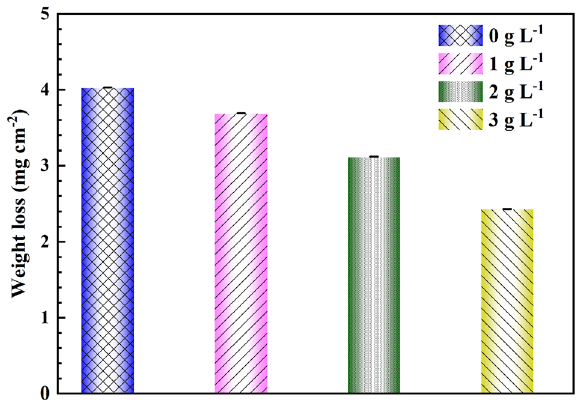
Fig. 7 Weight losses of X80 coupons. The samples were exposed to 3.5 wt% NaCl containing differient concentrations of Vibrio sp. EF187016 EPS after 72